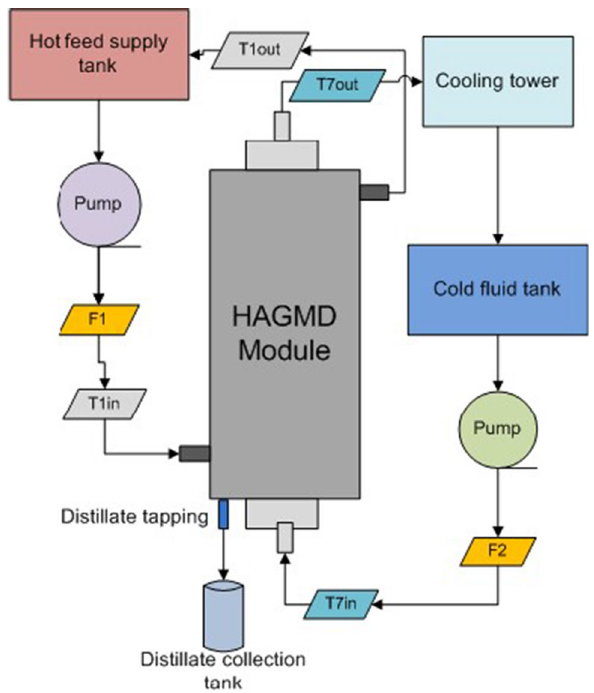
Fig. 5 Line sketch of HAGMD experimental